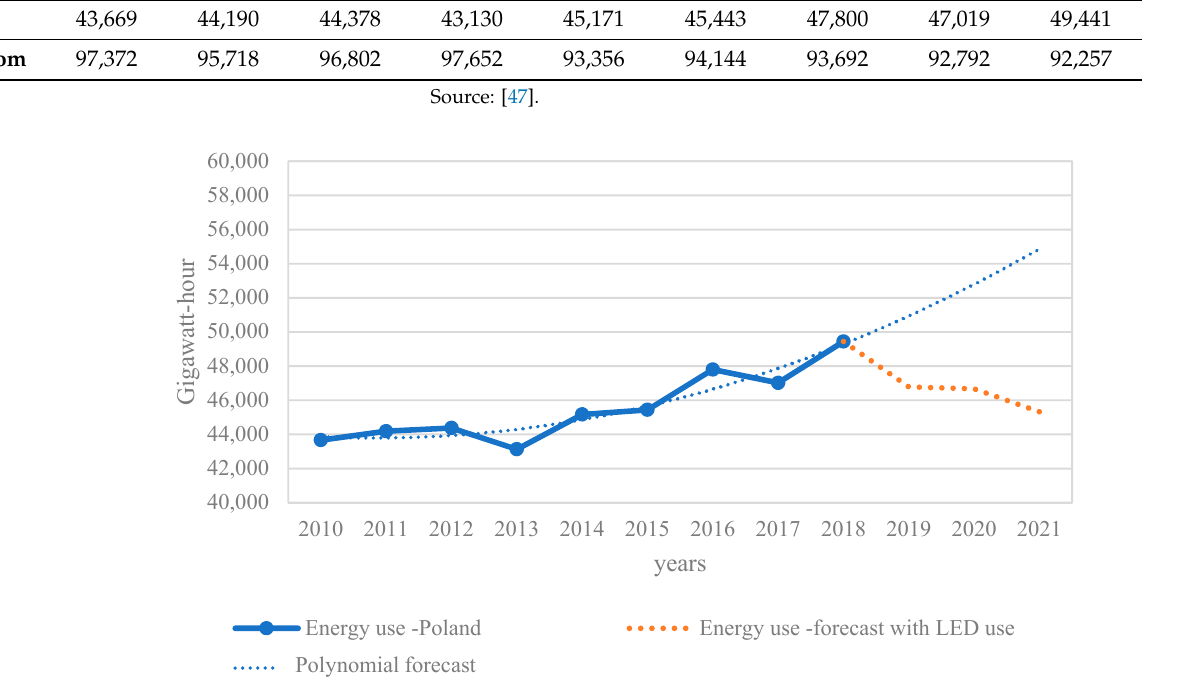
Figure 4. Energy use in commercial and public services with forecast—Poland. Source: [48].